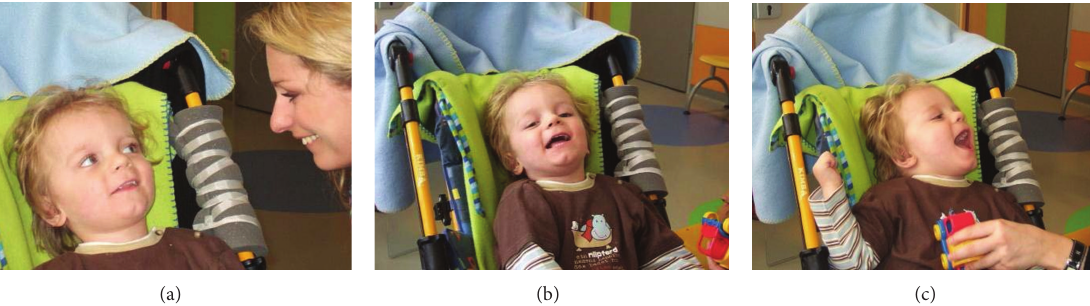
Figure 9: Two-month follow-up: (a) first social smiling of the patient (L. B.) towards his mother and (b), (c) laughing, when played with, 2 months after autologous transplantation of cord blood cells (i.e., 4 months and one week after severe brain damage caused by cardiac arrest). (see video S4 in Supplementary Material [44]). Table 1: Therapeutic responses to autologous cord blood infusion according to clinical characteristics and infused TNC counts. This